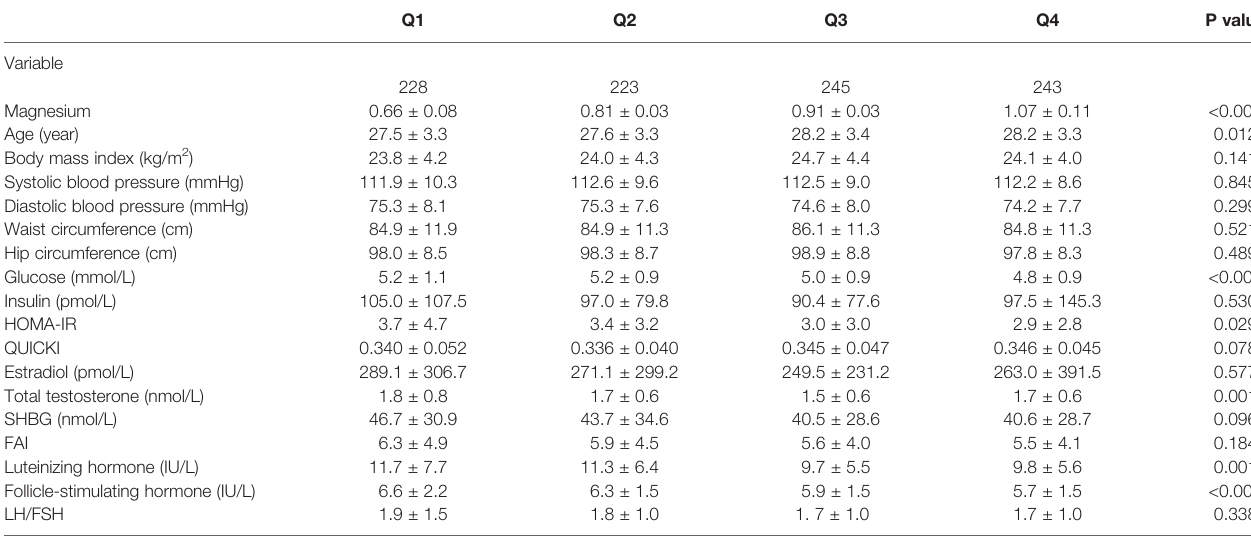
TABLE 1 | Characteristics of all women with PCOS in quartiles of serum